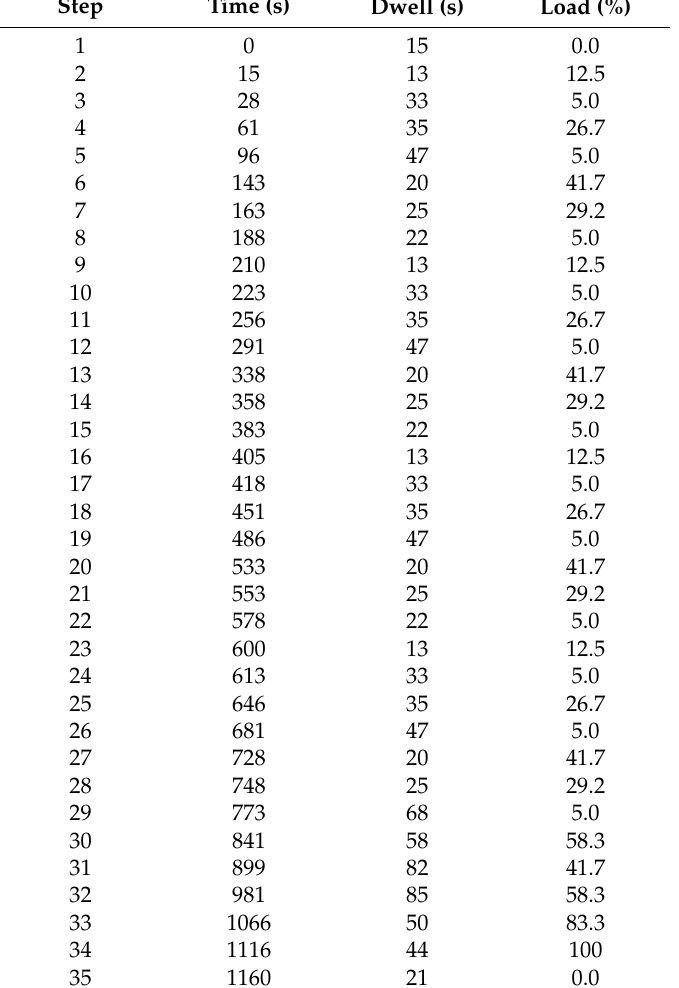
Table A2. Fuel cell dynamic load cycle set points, based on